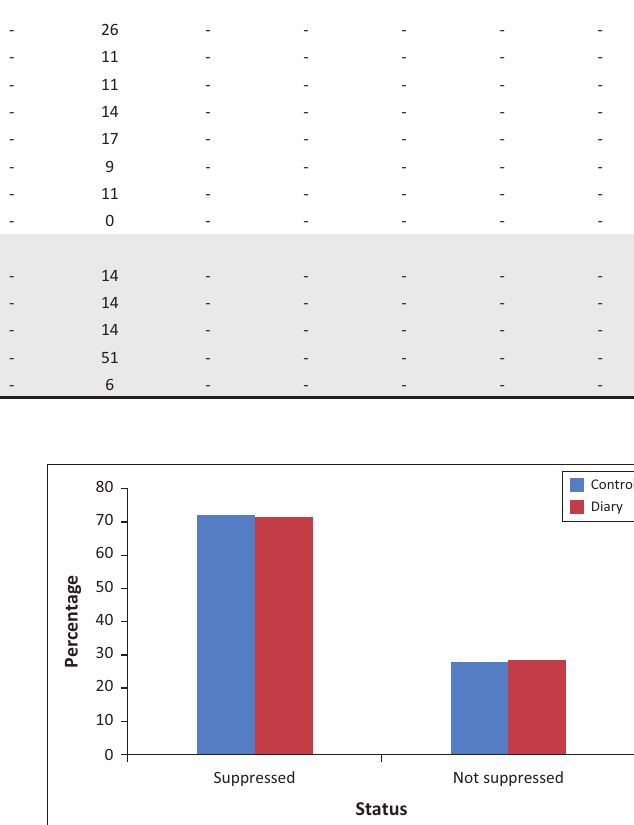
FIGURE 1: Viral load response at 6 months for both groups.